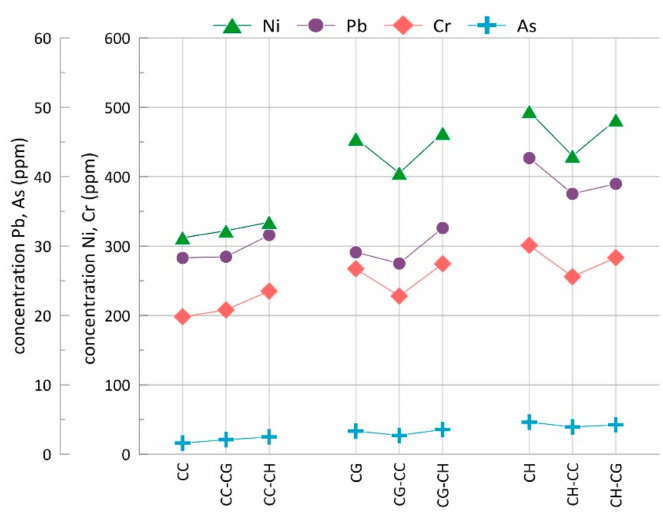
Figure 4. Distribution of toxic elements in the ashes of the examined raw